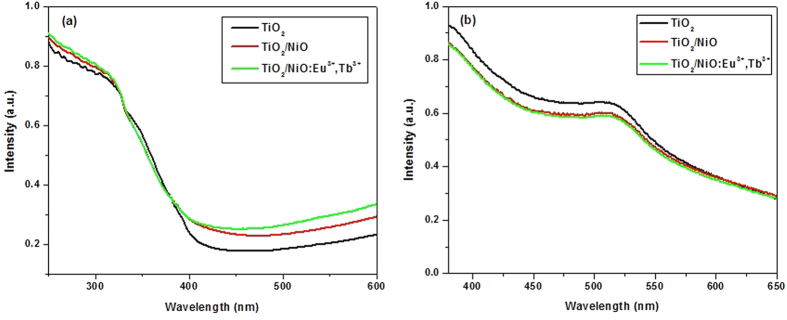
Absorption spectra of (a) TiO2, TiO2/NiO, TiO2/NiO:Eu3+,Tb3+ and (b) dye desorbed from different photoanodes.